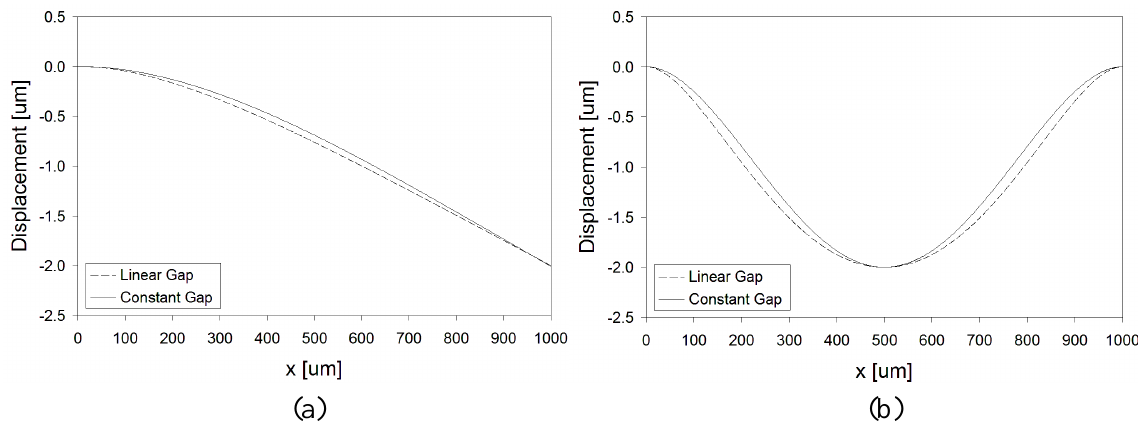
Figure 7. Linear gap beam displacement profiles (a) cantilever (b)